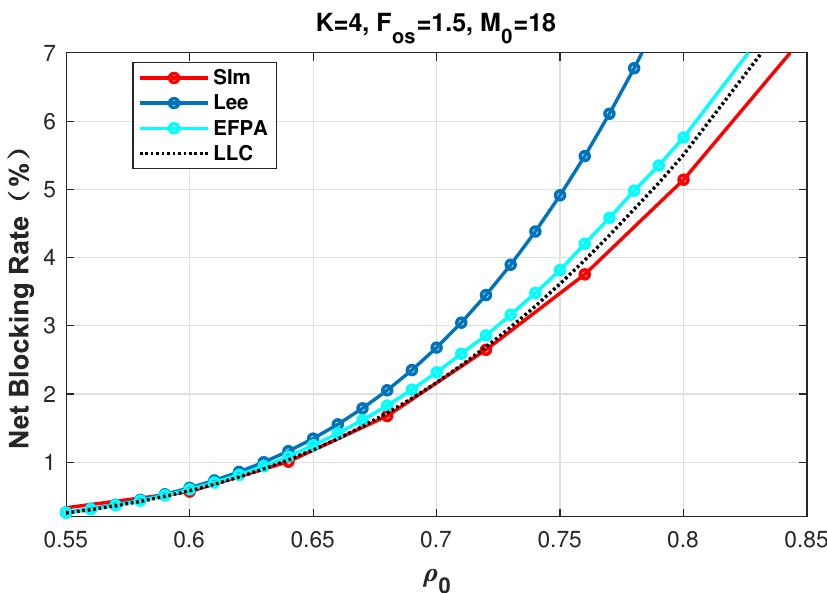
Figure 6. Network blocking performance of different methods with K = 4, F OS = 1.5, and M 0 = 18.